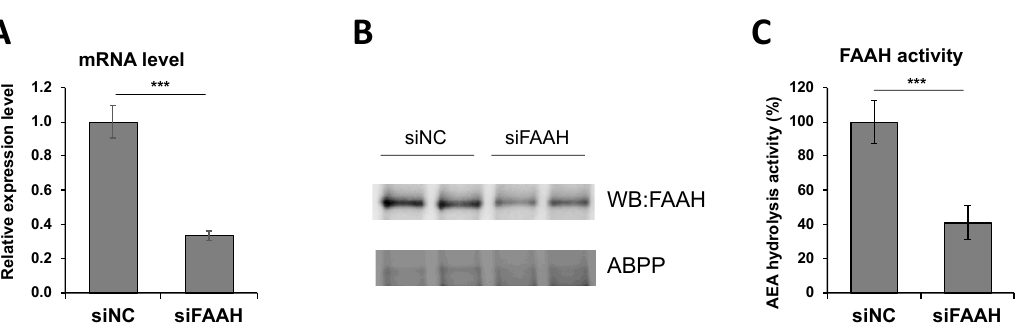
Figure 6. Characterization of FAAH siRNA knockdown cells. BV2 cells were transfected with siRNA for FAAH or negative control followed by 24 h incubation. FAAH mRNA expression was determined by qRT-PCR relative to GAPDH ( A ), and FAAH protein expression was assessed by western blotting and ABPP with FP-TAMRA probe ( B ). AEA hydrolysis activity in the membrane was measured as shown in Figure 1A ( C ). Data are presented as means ± S.D. (n = 3). *** denotes p < 0.001.